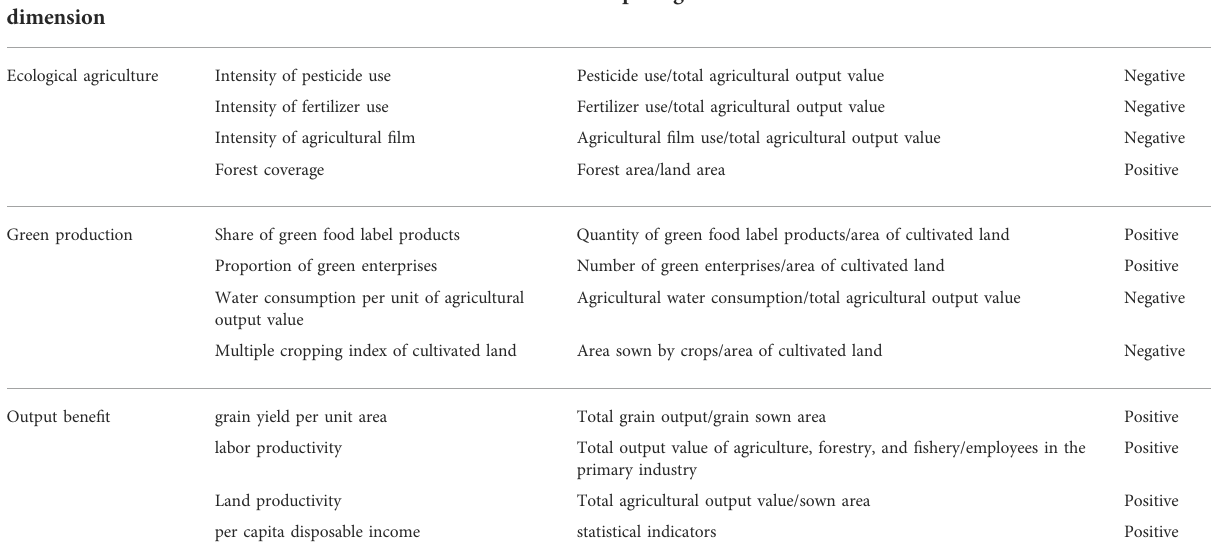
TABLE 1 Evaluation System of green agriculture development. Evaluation